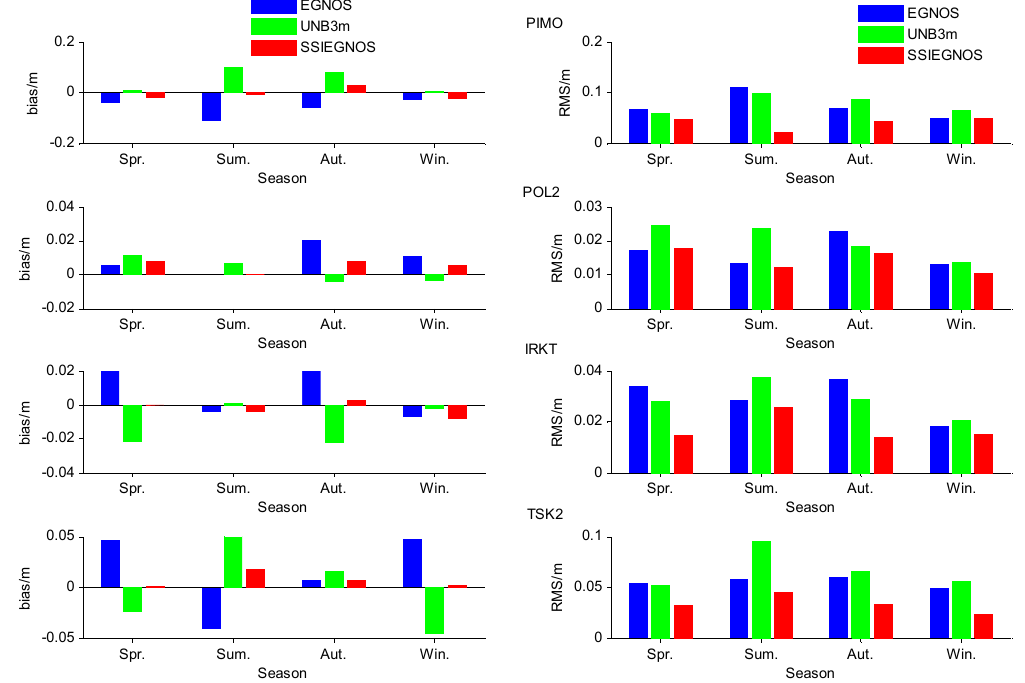
Figure 17. Seasonal mean predicted bias and RMS error from 2011–2012 at the TSK2, POL2, IRKT, and TSK2 sites. The blue bars, green bars and red bars denote the monthly bias and RMS error of the EGNOS, UNB3m, and SSIEGNOS models, respectively.